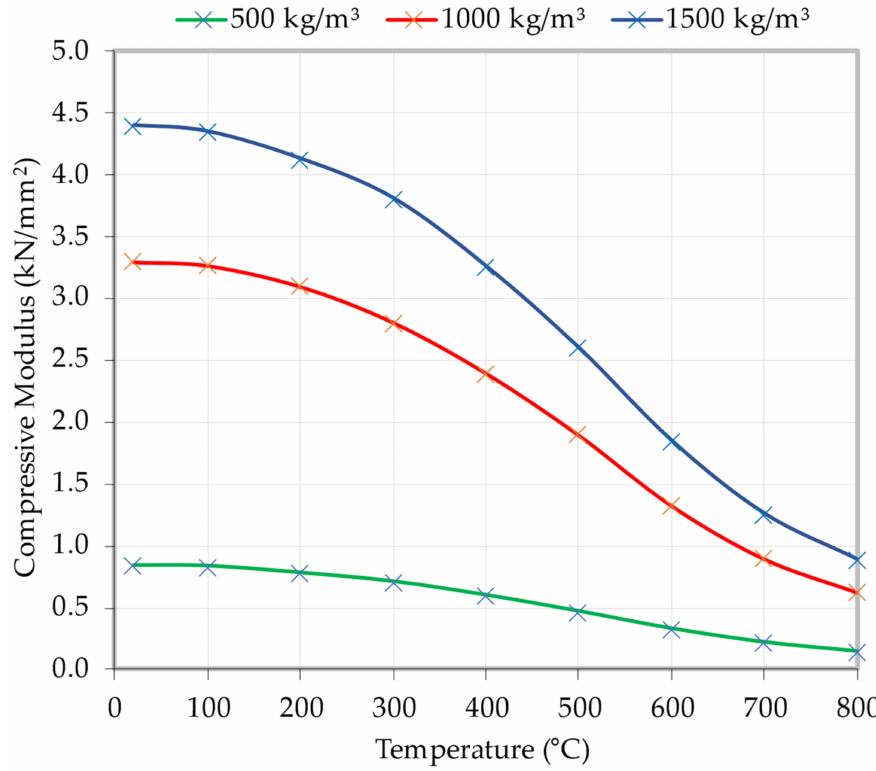
Figure 13. Influence of varying temperatures on the LFC compressive